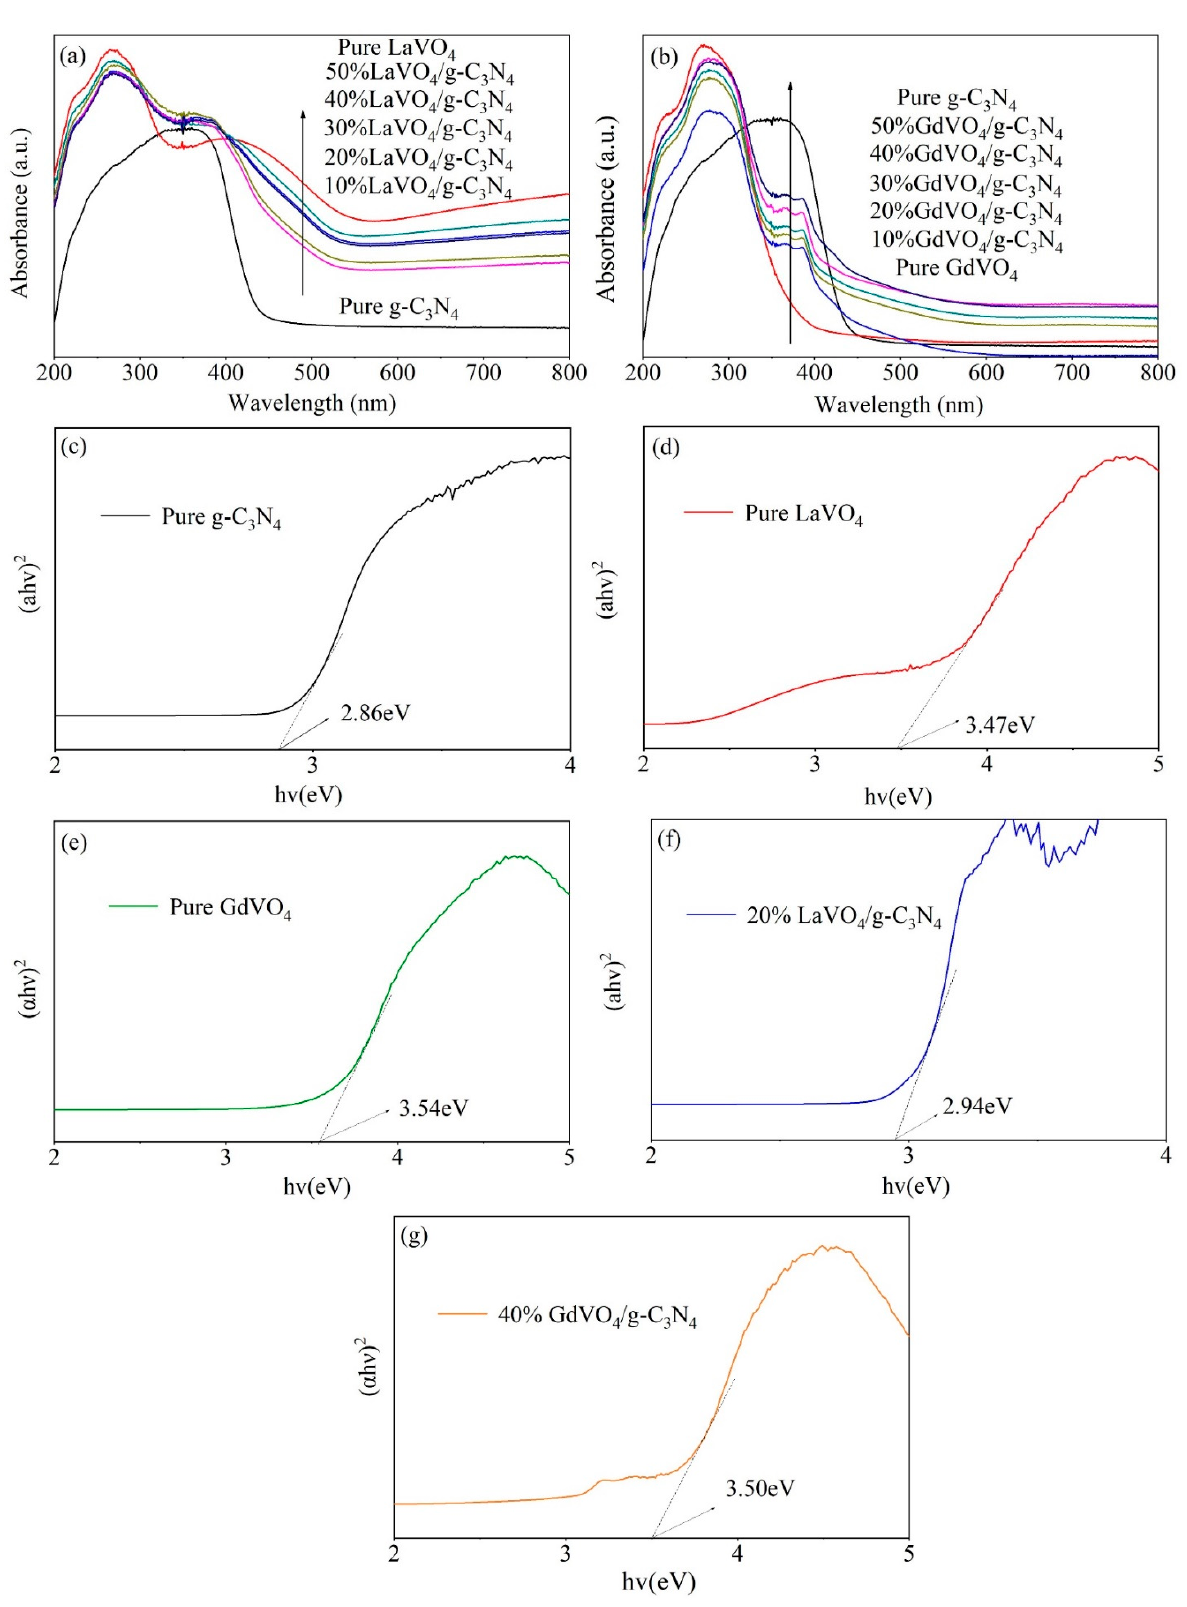
Figure 5. DRS spectra of ( a )10–50% LaVO 4 /g-C 3 N 4 , ( b ) 10–50%GdVO 4 /g-C 3 N 4 , and the band gaps of ( c ) g-C 3 N 4 , ( d ) LaVO 4 , ( e ) GdVO 4 , ( f ) 20% LaVO 4 /g-C 3 N 4 , and ( g ) 40% GdVO 4 /g-C 3 N